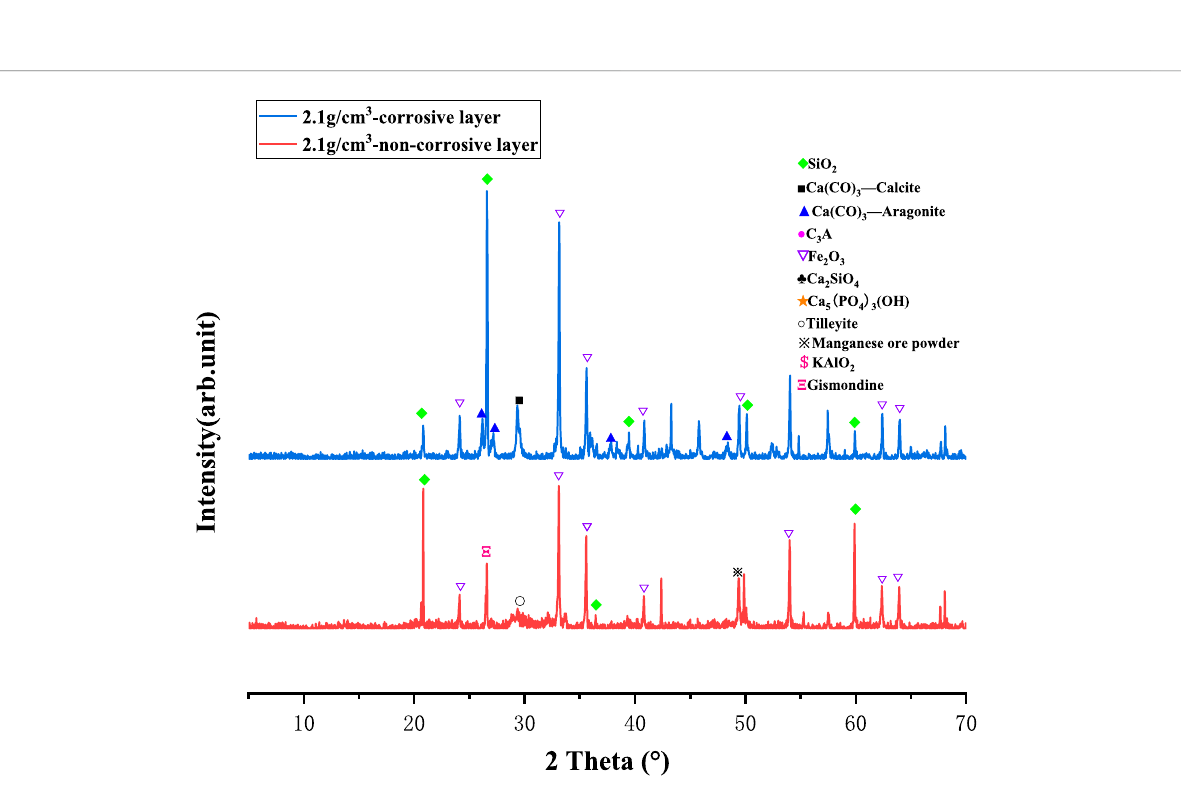
FIGURE 14 XRD spectra of internal and external corrosion of high-density BFs-HA-composite emulsion cement